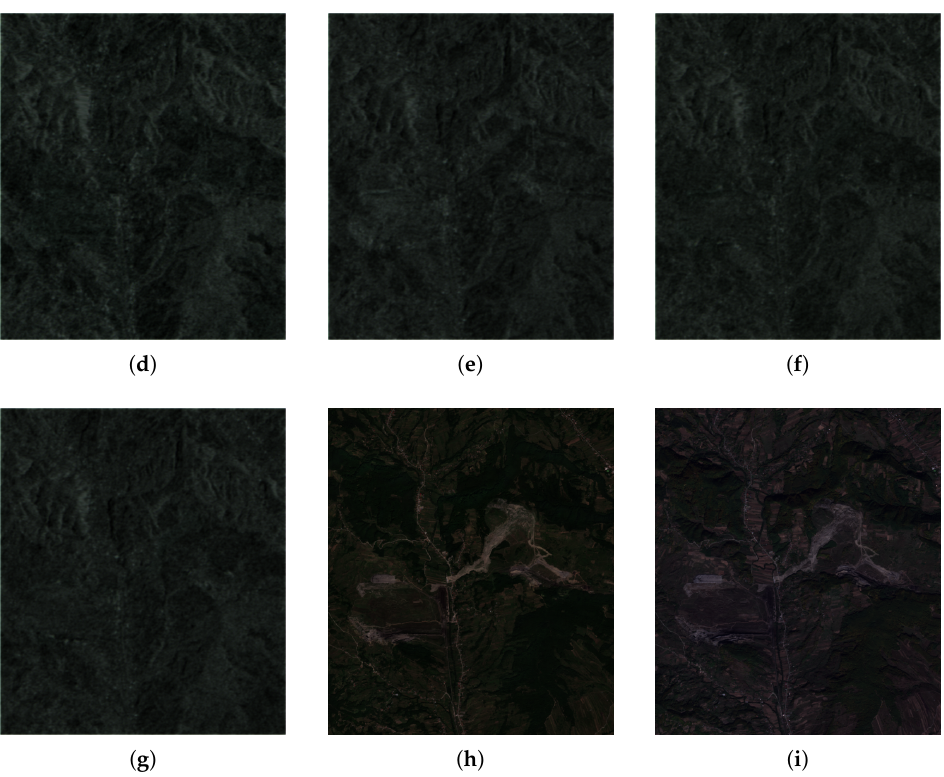
Figure 8. Original and generated SITS in the optical domain for landslide detection: ( a ) 18